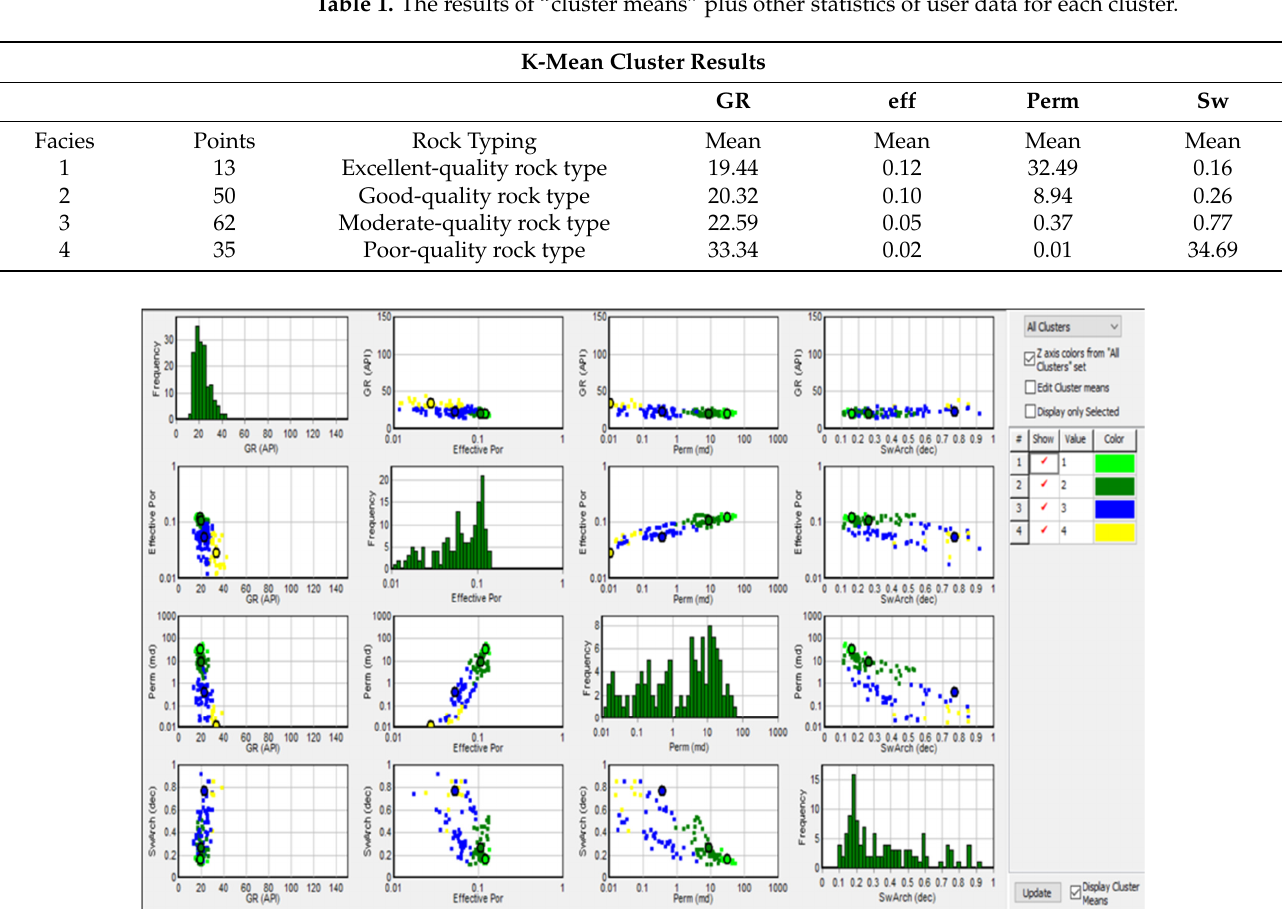
Figure 7. The final graphical result of clustering analysis.